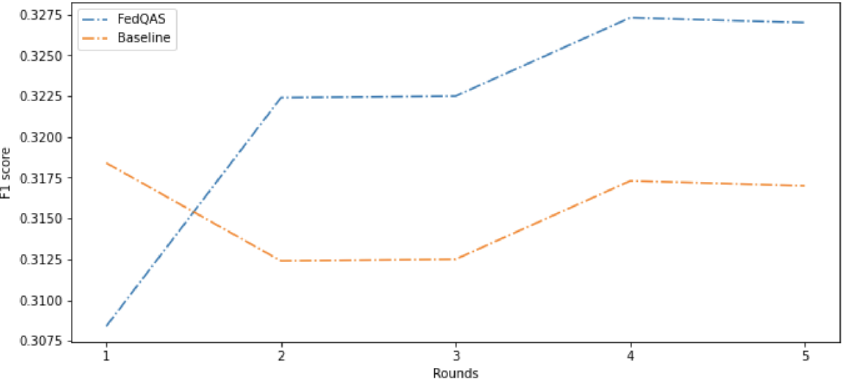
Figure 6. Convergence of F1 score on SQUAD dataset with 1 combiner, 5 clients and 5 rounds.